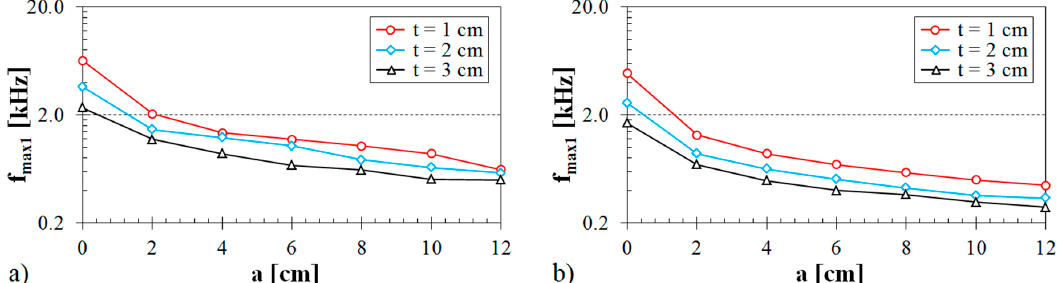
Figure 6. Influence of the air space size on the frequency dependencies of the sound absorption coefficient for the tested ABS samples: ( a ) Rhomboid structure, volume ratio V r = 44%, sample thickness t = 1 cm; ( b ) Starlit structure, volume ratio V r = 57%, sample thickness t = 2 cm.